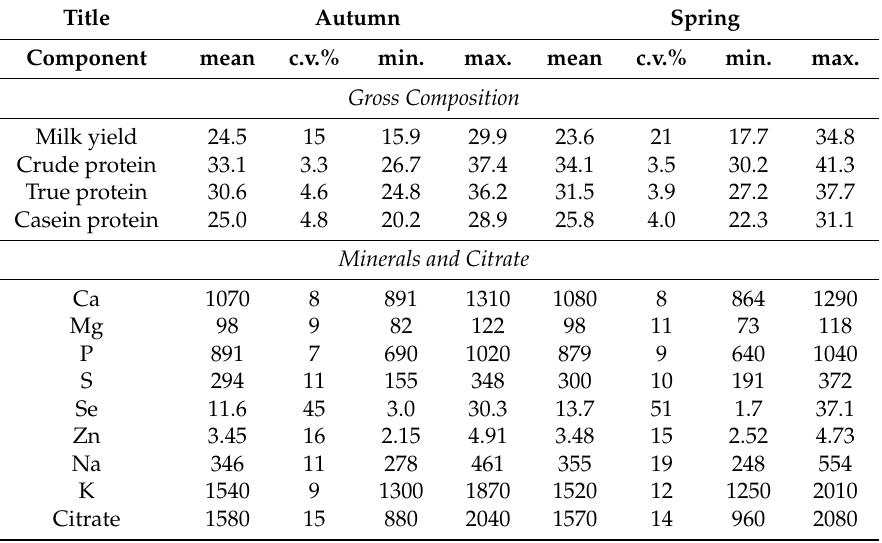
Table 3. Statistics summarizing the effects of autumn or spring calving, when averaged across all farms, on the yield, concentrations of protein fractions, minerals and citrate in milk 1